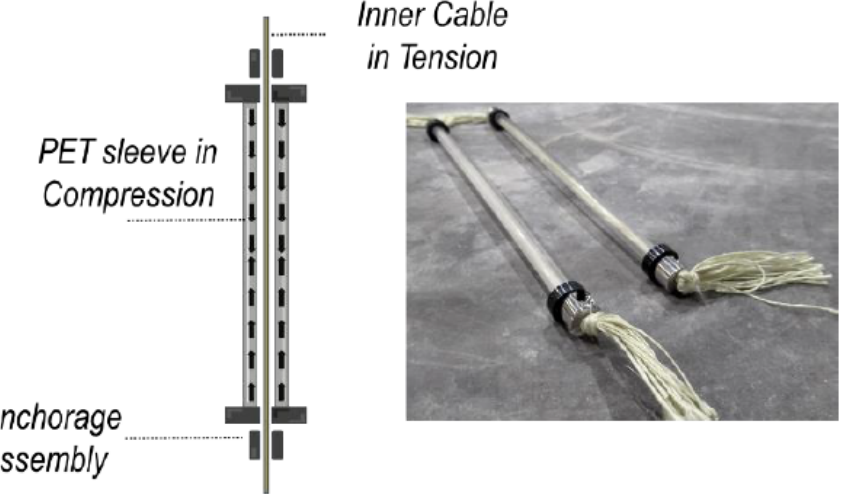
Figure 7. Hybrid device using inner pre-tensioned Kevlar strip (red) and SMP PET outer tube. Adapted from [44].